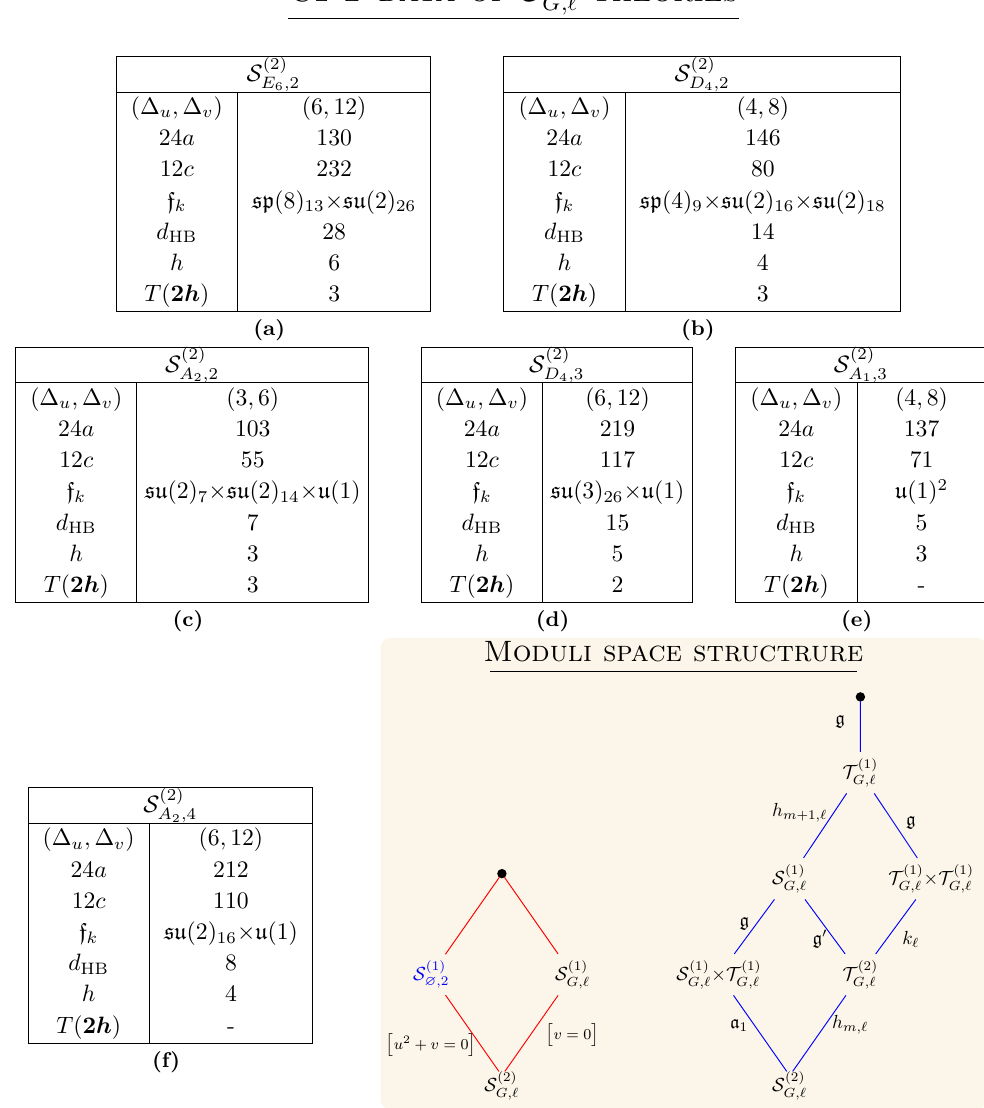
theories. The m , the k ‘ G,‘